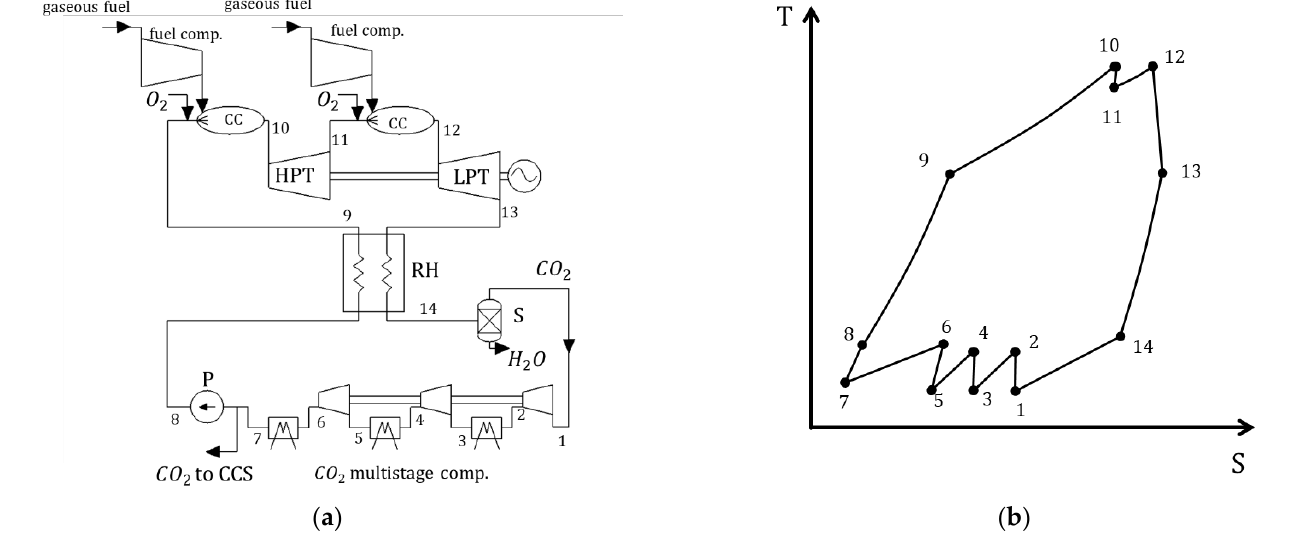
Figure 19. E-MATIANT cycle: ( a ) schematic diagram; ( b ) T – S diagram [34]. Comp. — compressor; CC — combustion chamber; LPT — low-pressure turbine; RH — regenerative heat exchanger; HPT — high-pressure turbine; S — separator; P — pump.